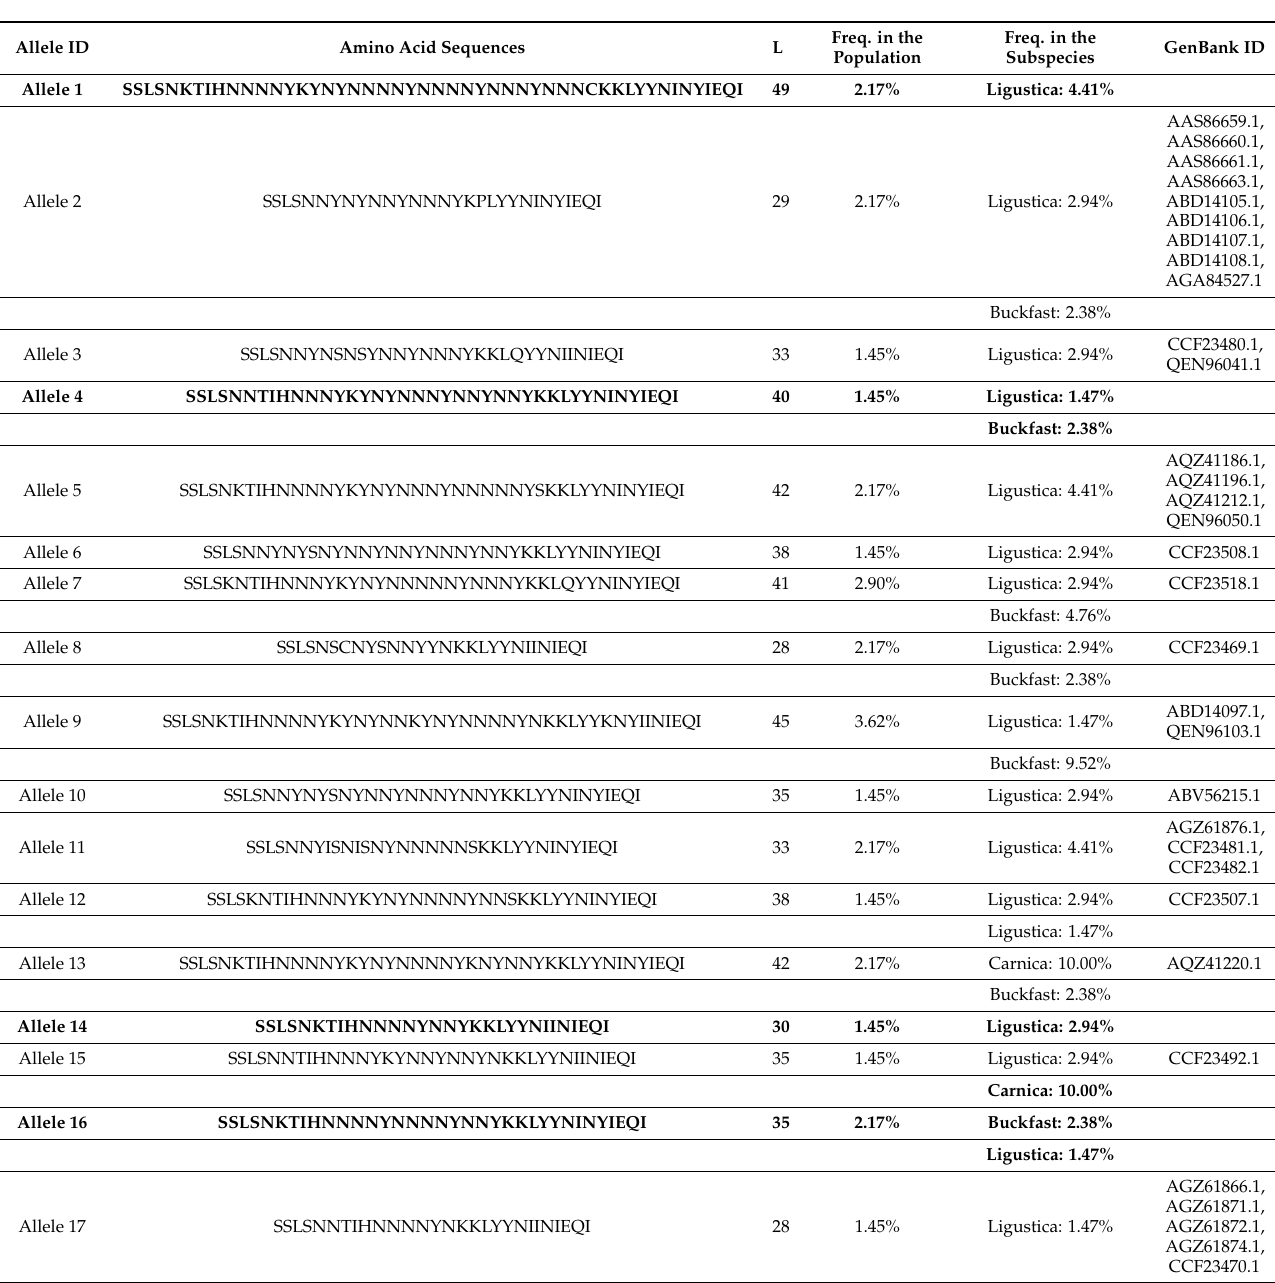
Table 1. Amino acid sequences of alleles belonging to the hypervariable region of the csd gene, their lengths (L = nr of aa) and frequencies. If the allele was identified in GenBank, the accession numbers are shown (GenBank ID). In bold are the novel alleles identified in the